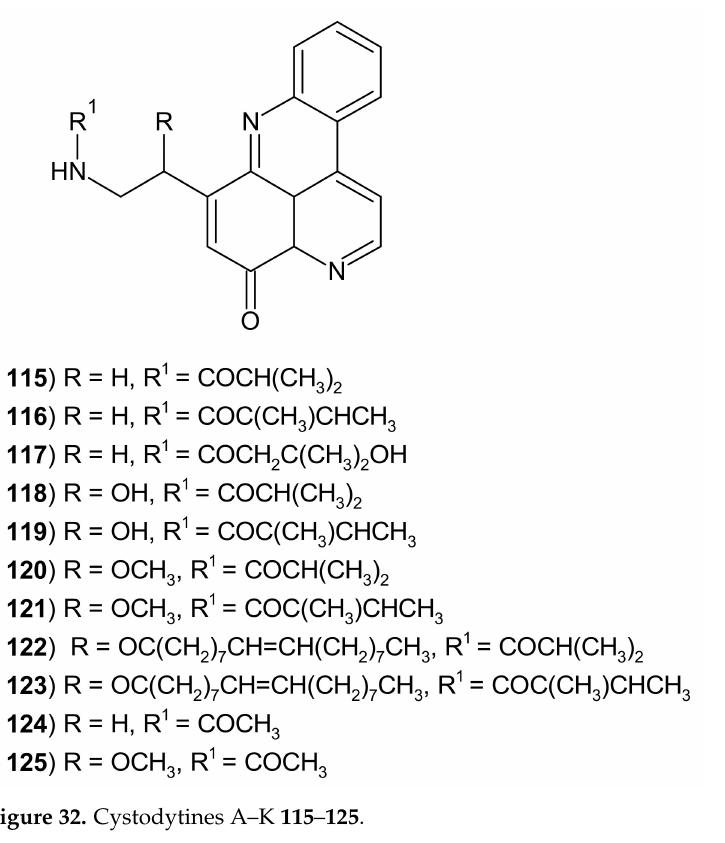
Figure 32. Cystodytines A–K 115 – 125 .